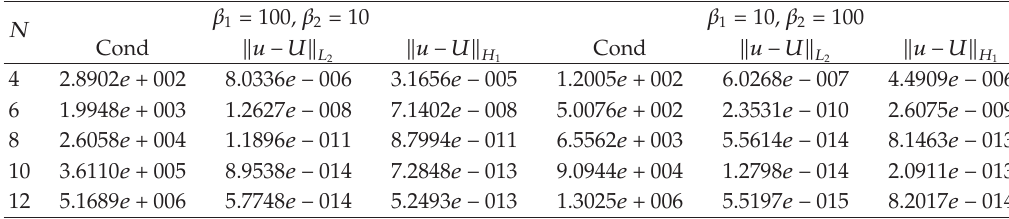
Table 1: Convergence analysis of Example 4.1 by Galerkin